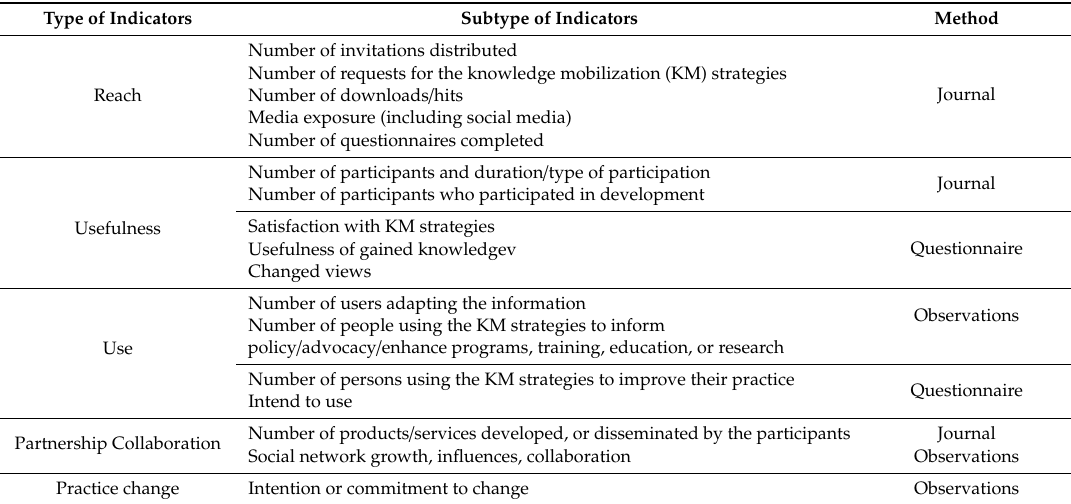
Table 1. Mobilization Indicators and Methods Used to Assess